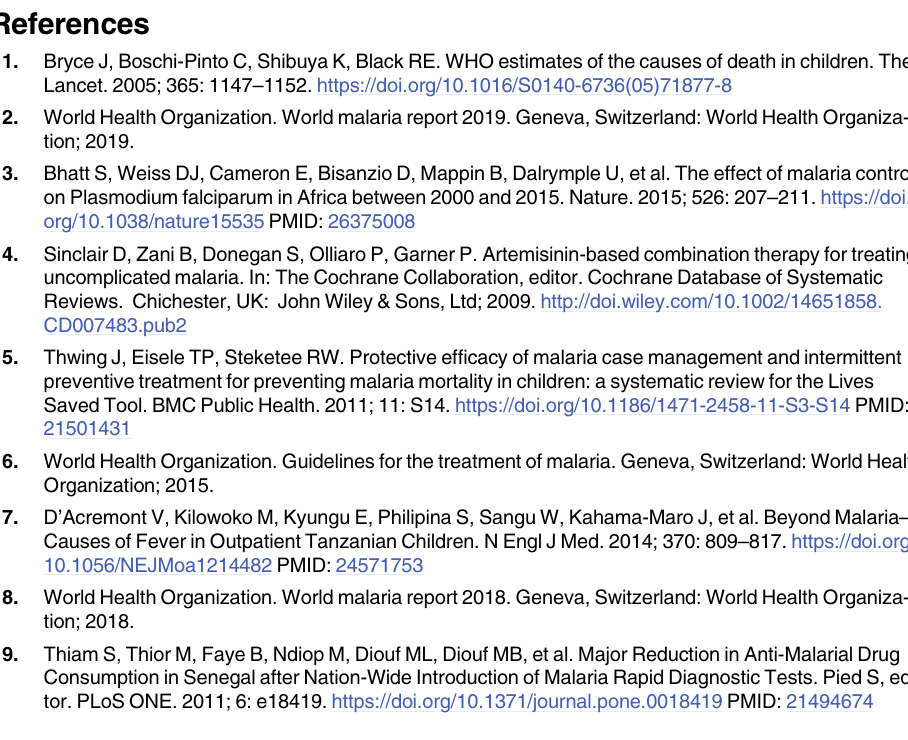
S3 Table. Clinical management of children diagnosed with malaria: Estimates by time period, country, hospital, and leaving one country out at a time. S4 Table. Antimalarial prescriptions among children diagnosed with malaria. S5 Table. Patient, provider, and facility correlates with receipt of blood test diagnosis and recommended medication for malaria (logistic regression)—crude